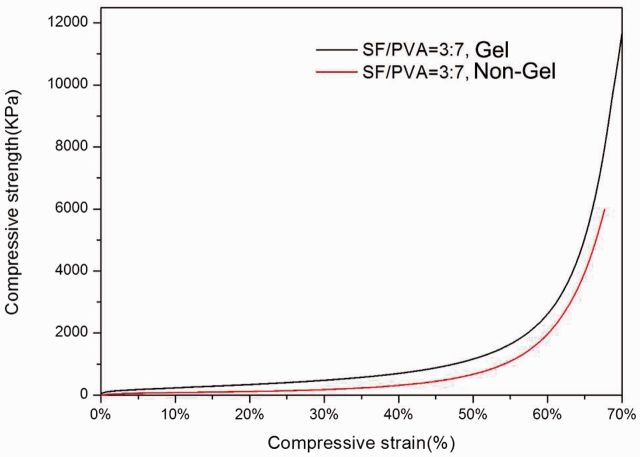
Compressive stress–strain curves for SF/PVA blend scaffolds with and without gelation process